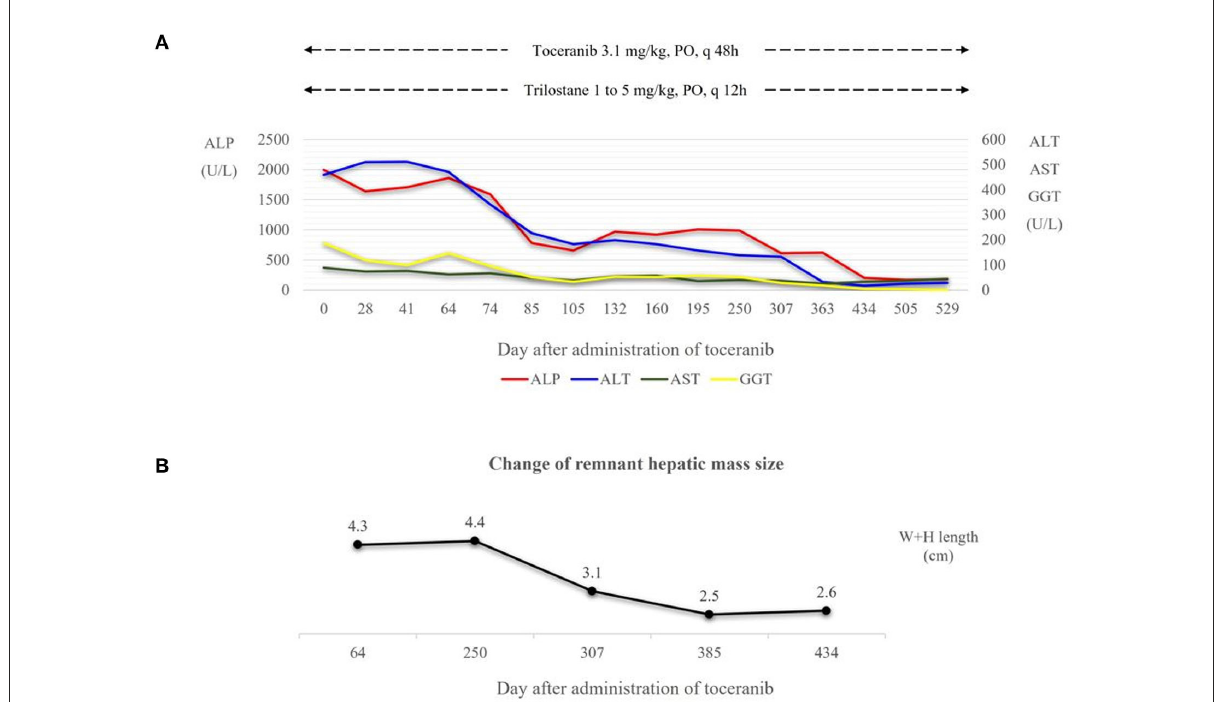
FIGURE4 (A) Dose of toceranib and trilostane administered and hepatic enzyme level following the administration of toceranib. Trilostane was prescribed at initial presentation and dose escalation was conducted according to the ACTH stimulation test results and clinical signs of hyperadrenocorticism. At toceranib day 74, trilostane was escalated to the final dose (5 mg/kg, PO, q12h). Hepatic enzyme levels decreased gradually after the administration of toceranib, and the levels of all four hepatic enzymes appeared within the normal range since toceranib day 434. (B) Change in the remnant hepatic mass size in terms of the sum of its width and height measured on abdominal ultrasonography. The mass size was measured to 2.3 × 2.0cm on toceranib day 64, 1.7 × 1.4cm on toceranib day 307, and 1.6 × 1.0cm on toceranib day 434. ALP, Alkaline Phosphatase. ALT, Alanine Aminotransferase. AST, Aspartate Aminotransferase. GGT, Gamma Glutamyltransferase. W + H length, width plus height